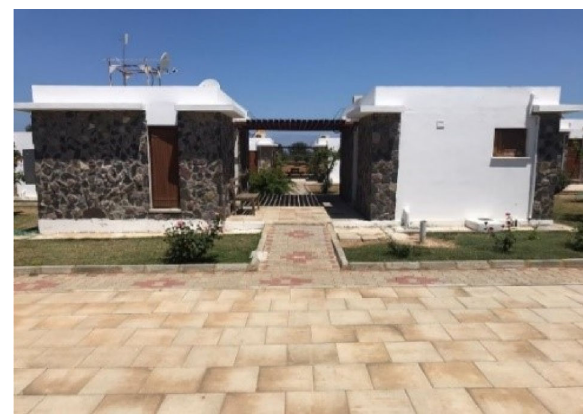
Fig. 8 Karpasia Natura Guest House — Risokarpaso. Example of reinforced concrete construction.